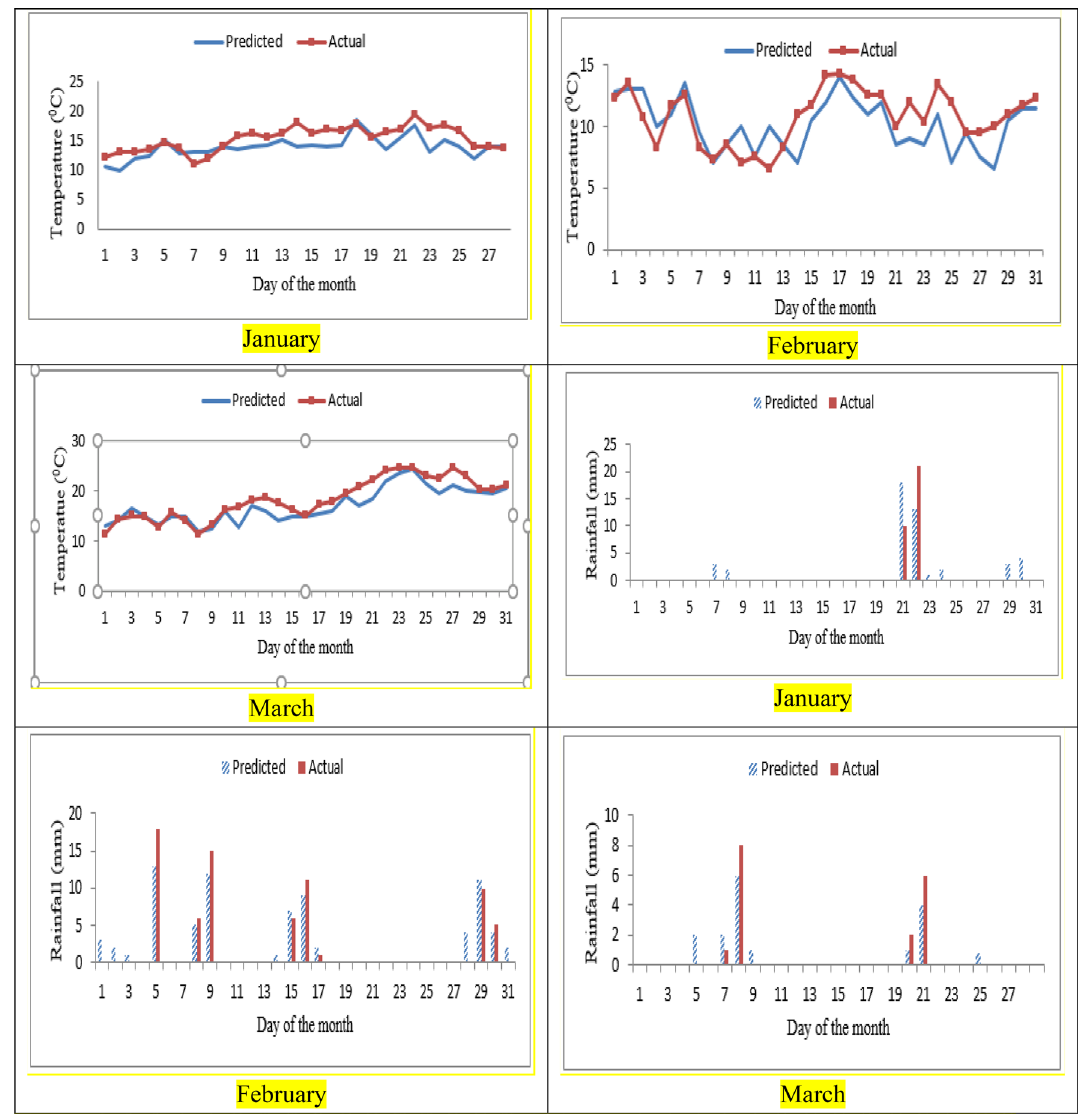
Fig. 9 Plot of actual and predicted temperature and rainfall comparison for Dera Ismail Khan station. Data Source : Regional Meteorological